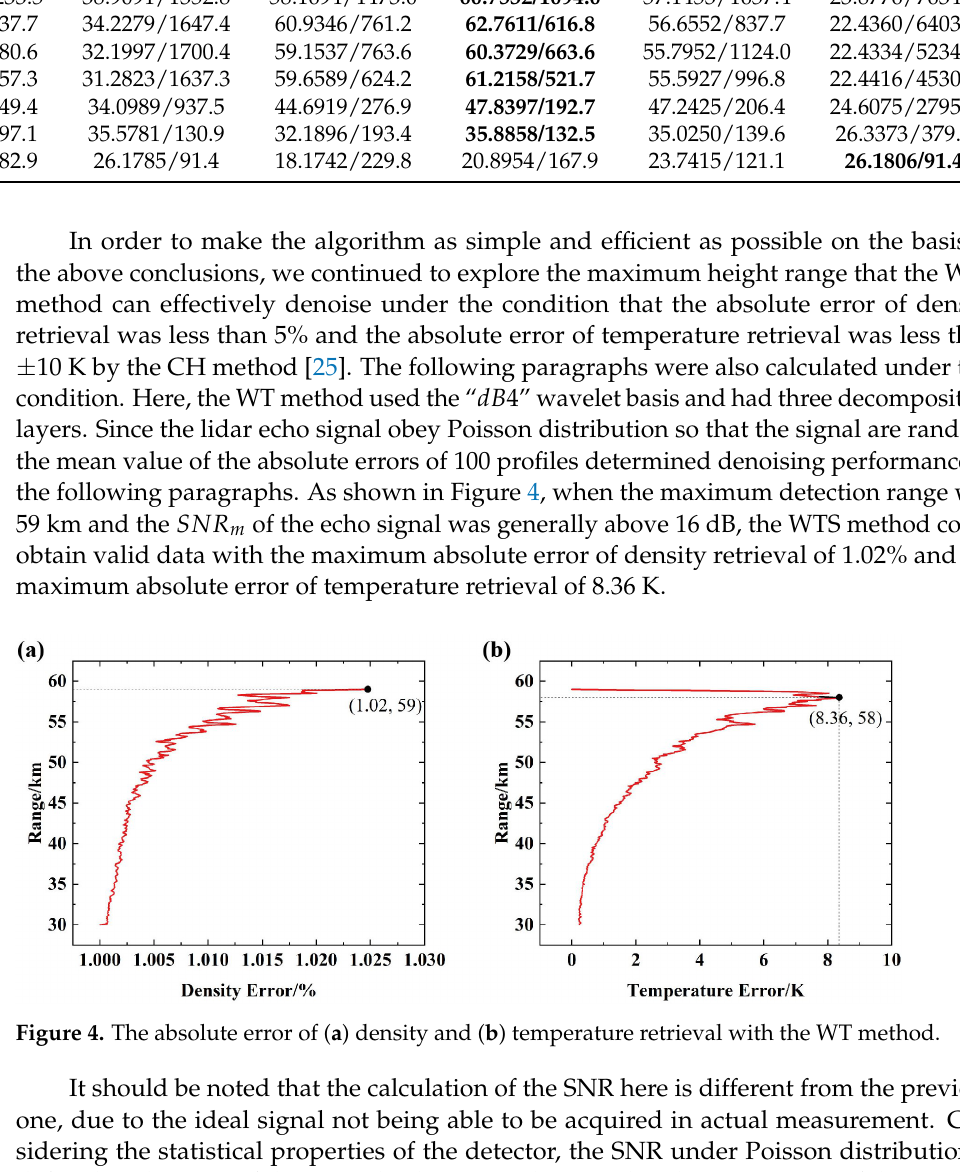
where P raw ( z ) is the original echo signal and BG is the background noise. Figure 5 shows the change SNR m with